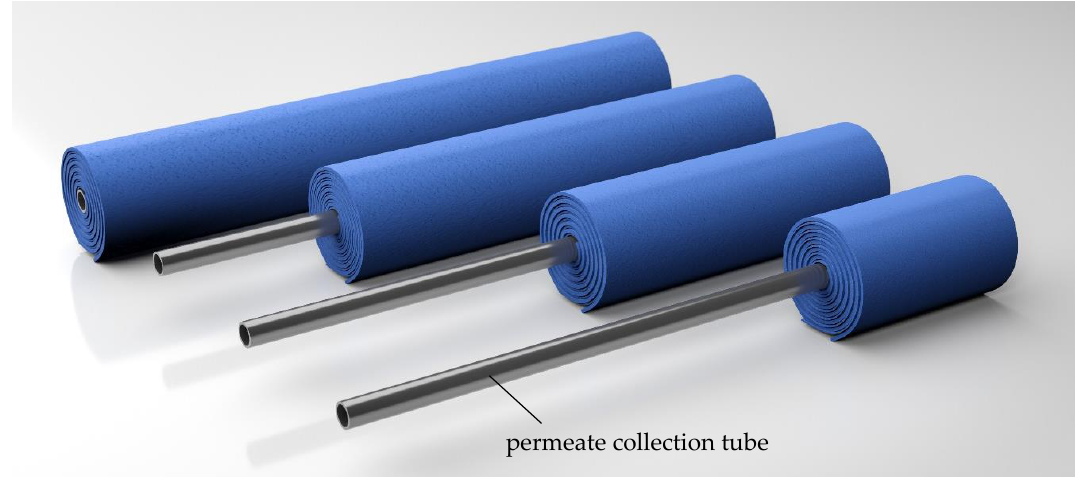
Figure 4. Membranes with different lengths (0.24; 0.48; 0.72; 0.96 m). For all modules, the permeate collection tube has a length of 0.96 m.